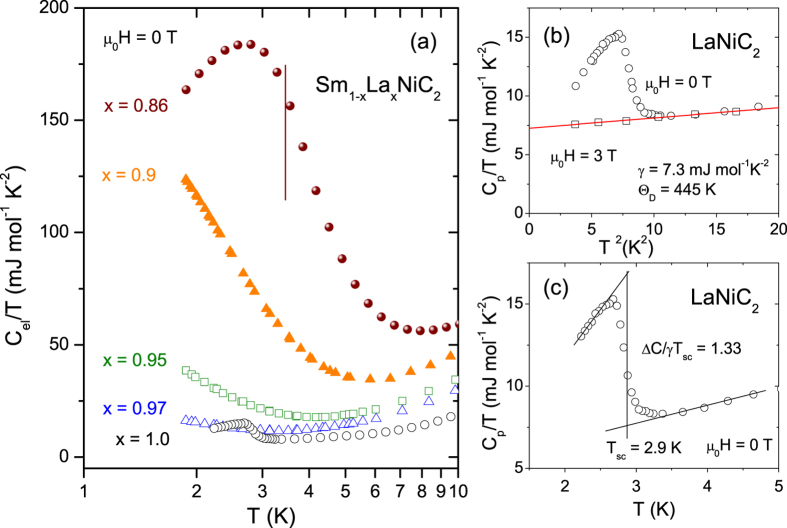
Low temperature specific heat data of Sm1−xLaxNiC2 (0.86 < x < 1.0).The vertical line mark the Curie temperature estimated from the Arrott plot of the magnetization. Panel (b) shows Cp/T versus T 2 for LaNiC2 under zero magnetic field (open circles) and 3T (open squares). The solid red line represents fit to Cp/T = γ + βT2. Panel (c) shows Cp/T versus Tsc in the vicinity of superconducting transition. Solid line shows the equal entropy construction.